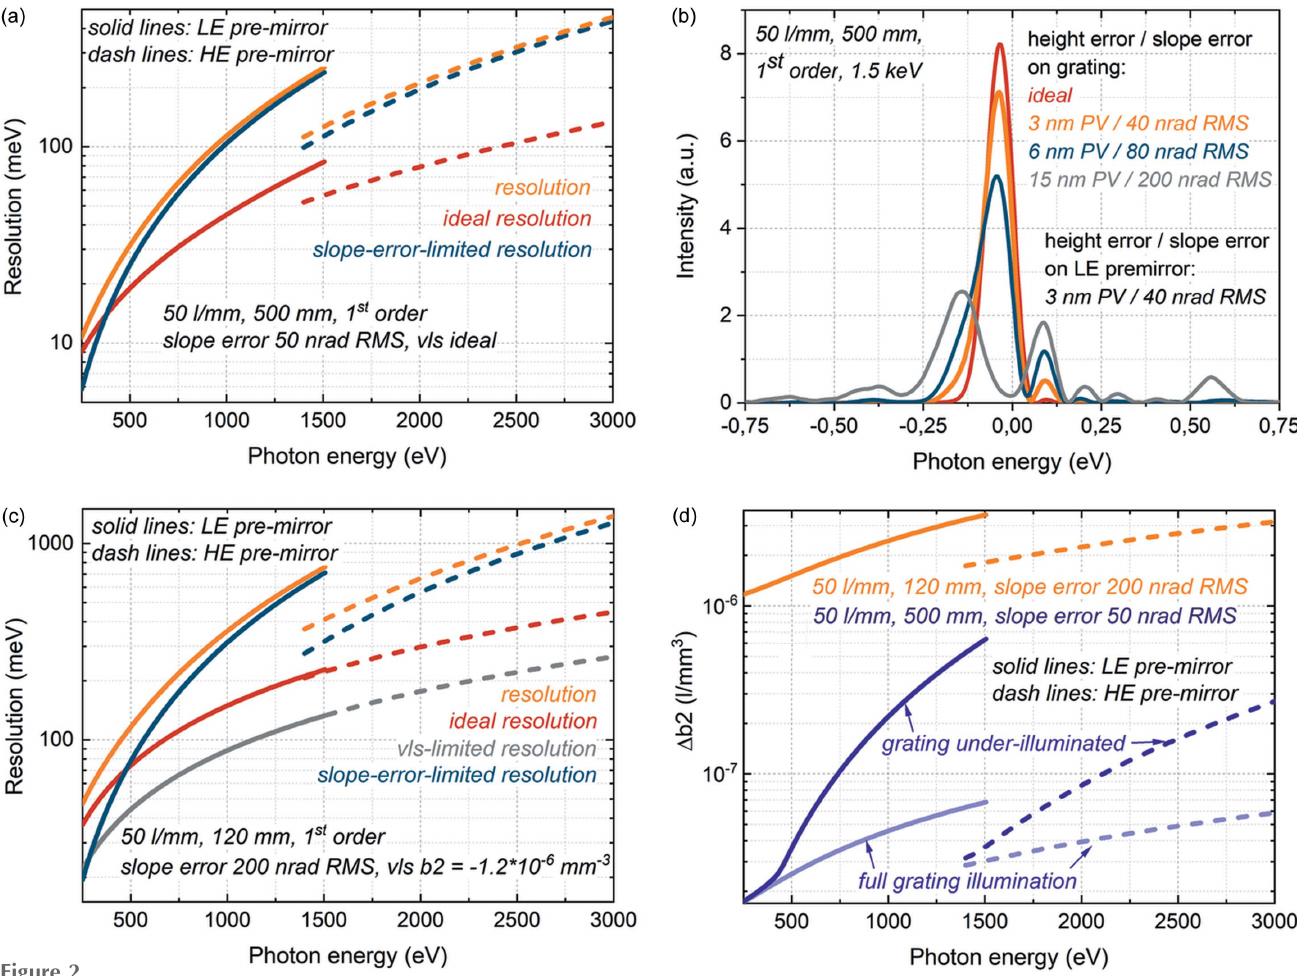
Figure 2 Influence of figure error and VLS miscut on resolution. ( a , c ) Analytically estimated resolution of the monochromator operating in first diffraction order with designed and installed 50 l mm (cid:2) 1 gratings; slope error on premirror 50 nrad RMS. ( b ) Instrument response function of the 500 mm-long 50 l mm (cid:2) 1 designed grating operating in first diffraction order at 1.5 keV obtained by wavefront propagation simulations for the cases of different magnitudes of slope error on the grating. ( d ) Analytically estimated tolerances on the VLS b 2 parameter for the 500 mm-long 50 l mm (cid:2) 1 designed grating and for the 120 mm-long 50 l mm (cid:2) 1